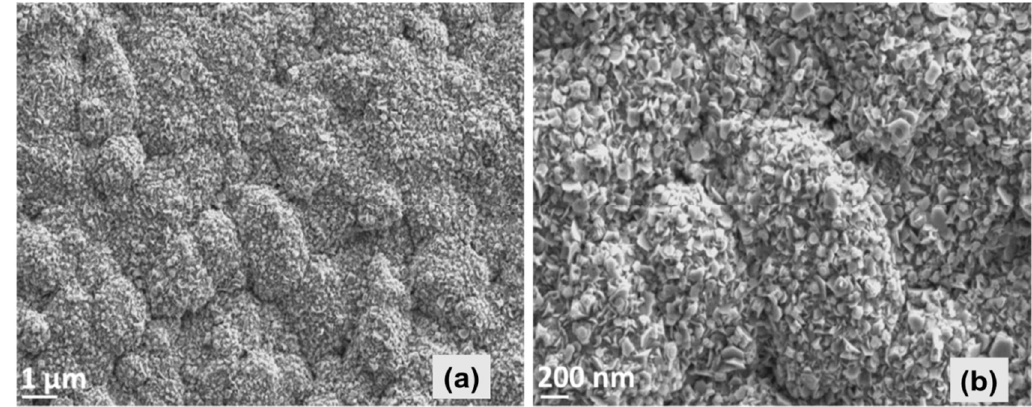
Figure 2. SEM images displaying the top view morphology of ZnO thin film at low (a) and high (b) magnifications.